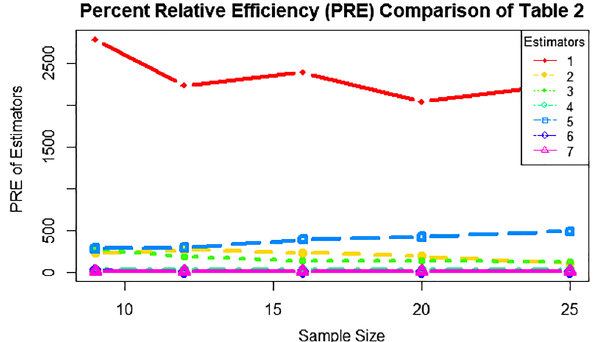
Figure 1. Above are the PRE of estimators with respect to different sample sizes, whereas T1, T3, T4, T5, T6, T7 and T8 are presented in red, yellow, green, aqua blue, light blue, purple and pink colors, respectively.